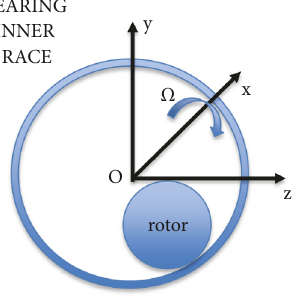
Figure 19: Rotor angular speed convention: rotor positive angular speed is